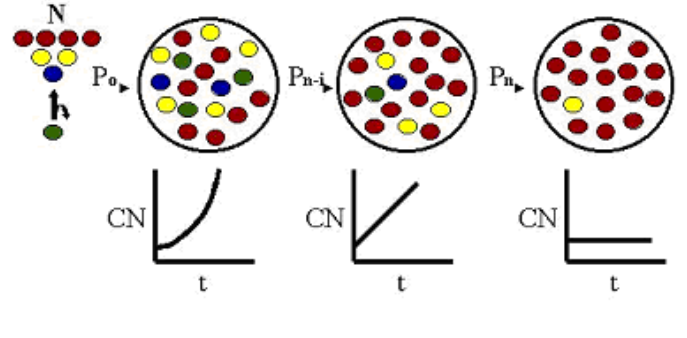
FIGURE 2. The asymmetric cell kinetics barrier to expansion of adult stem cells in culture. When tissue cells are explanted to culture, a large number (N) of adult stem cell–based tissue turnover units is obtained. Green circles represent adult stem cells, blue and yellow circles indicate differentiating transit cells, and red circles depict mature, terminally arrested cells that together comprise the basic turnover unit. It is postulated that in culture these tissue units regain their basic asymmetric cell kinetics, even though phenotypic differentiation of progeny cells is not restored. Because adult stem cell number does not increase during asymmetric cell kinetics, the stem cell fraction decreases with time as transit cells accumulate and fill up culture vessels. After the initial transfer of cells to culture ( Po ), successive dilutions of replete cultures ( Pn-i ) eventually yield a culture dilution in which no stem cells are transferred ( Pn ). This event is soon followed by a complete replicative arrest of the culture when all transit cells complete terminal maturation and division arrest[25]. Schematic graphs (cell number, CN vs. time, t ) depict change in growth rate with successive passages in